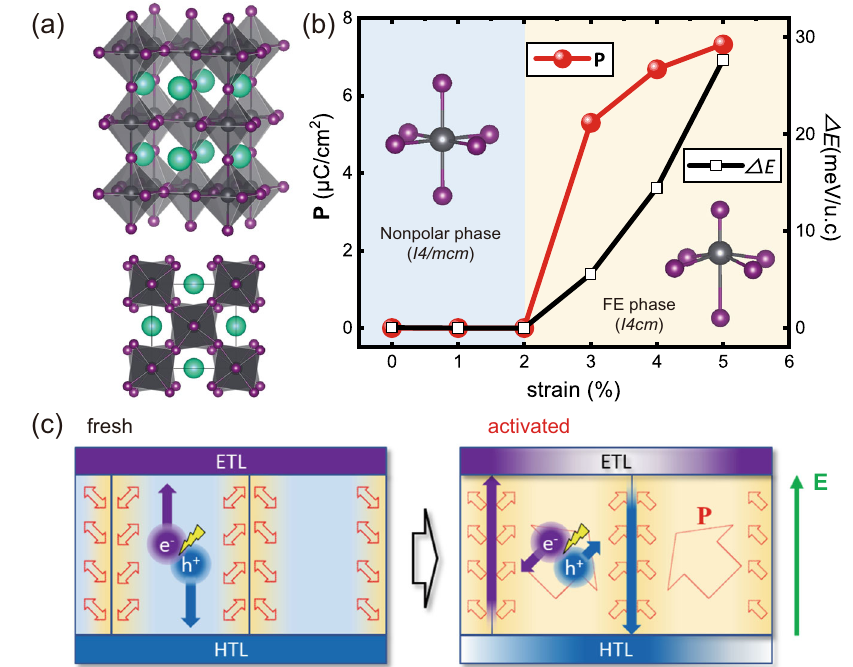
Fig. 4 | Synergistic effect offerroelasticity and photovoltaic.a Crystalstructure of tetragonal CsPbI 3 in our fi rst-principles simulations. ( b ) Structural phase tran- sition and ferroelectric polarization induced by strain. The nonpolar phase has a space group of I4/mcm , while the ferroelectric phase has a space group of I4cm . c Schematic illustration of the effect of lattice polarization on suppressing non- radiative recombination in electrically activated MAPbI x Cl 3-x twin-domains. For